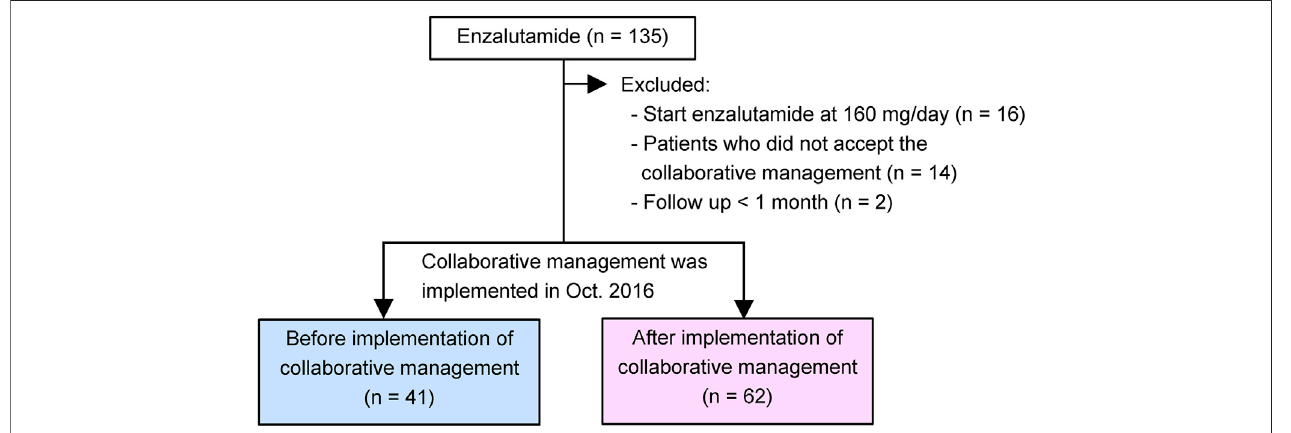
FIGURE 2 | Study diagram. Our pharmacist-urologist collaborative management was implemented in October 2016. Patients who started enzalutamide until September 2016 were allocated to the before group ( n = 41), and patients who started enzalutamide afterwards were placed in the after group ( n =